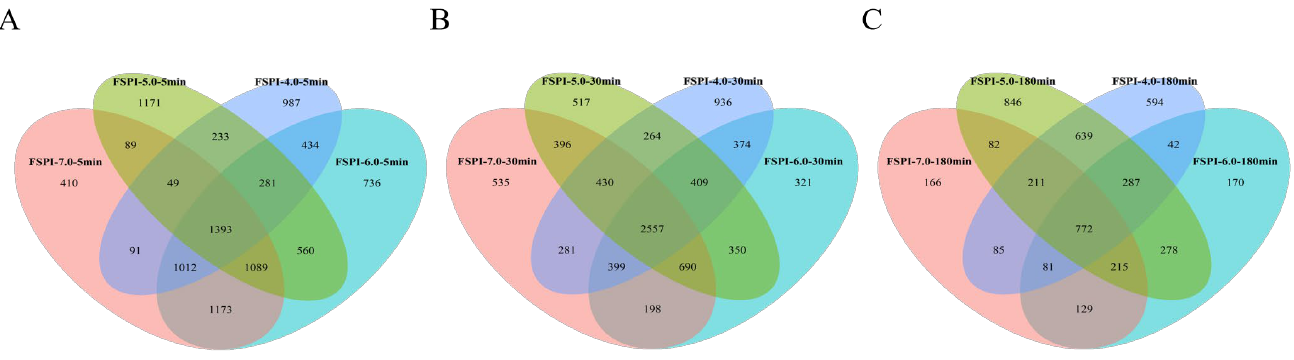
Figure 6. Venn diagram of the numbers of similar and unique peptides in the FSPI gastrointestinal digestates during dynamic intestinal digestion at ( A ) 5 min, ( B ) 30 min, and ( C ) 180 min.